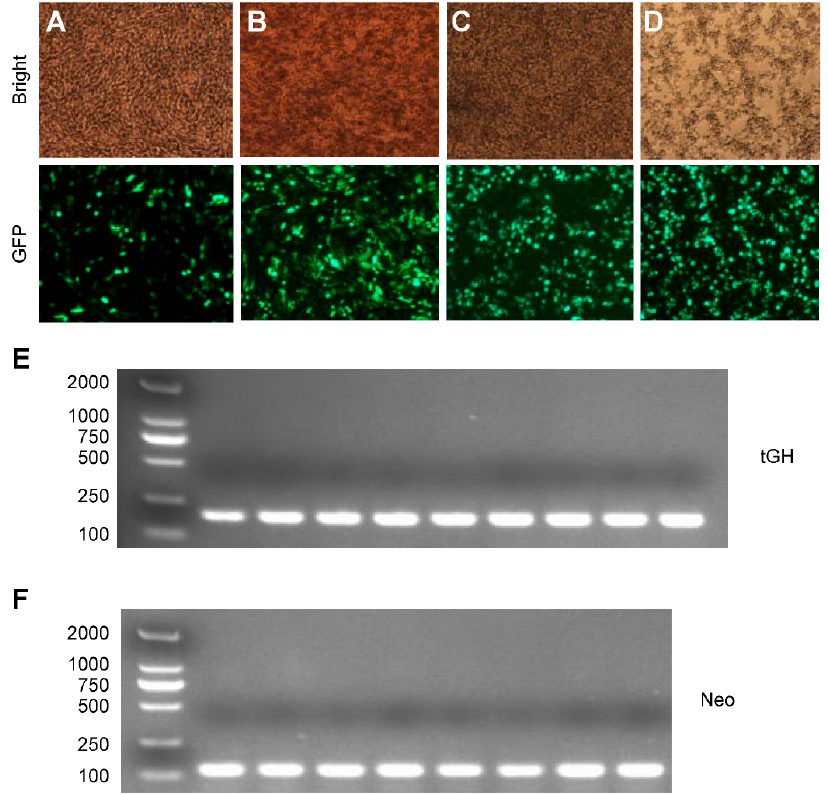
Figure 3. Cells at 48 h post-transfection with pcDNA3.1-EGFP and the RT-PCR product formed following the induction of Reeves’ turtle GH gene expression. ( A ) DF-1 cell line; ( B ) CHO cell line; ( C ) 293FT cell line; ( D ) GH4C1 cell line. Each cell line was transfected with 2 µ L of Lipofectamine and a total of 1200 ng of DNA (40×); ( E ) Electrophoresis map showing the PCR products generated from the transfected cell lines. The lanes showing pcDNA3.1tGH-6H and pcDNA3.1tGH-in-6H were chosen at random from the four cell lines; ( F ) Electrophoresis map of the neo gene PCR product. All of the vectors contained the neo gene, which served as an internal transfection control.